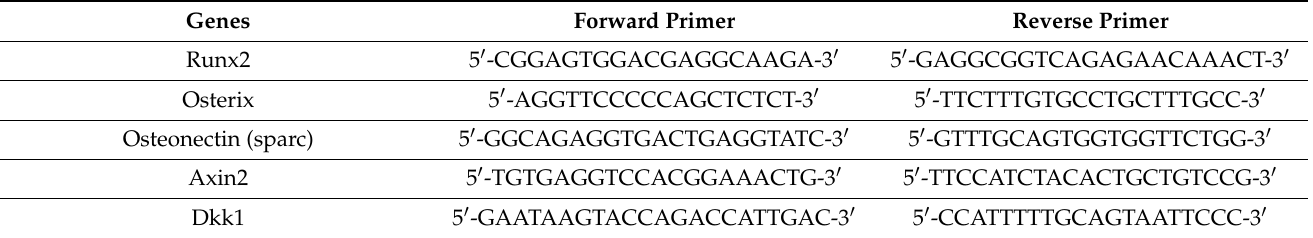
Table 1. List of primers used for RT-PCR